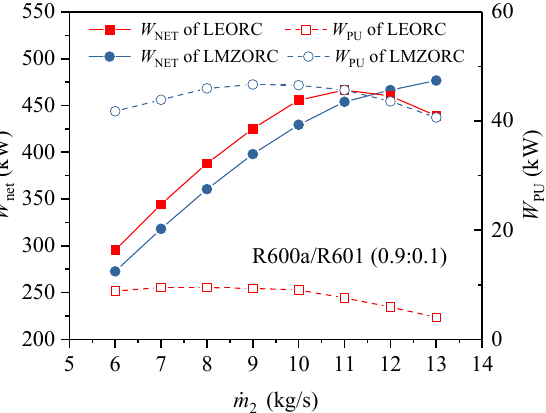
Figure 17. System configuration of LEOCR [84]. Reproduced with permission from Huang et al., Energy; published by Elsevier, 2022.